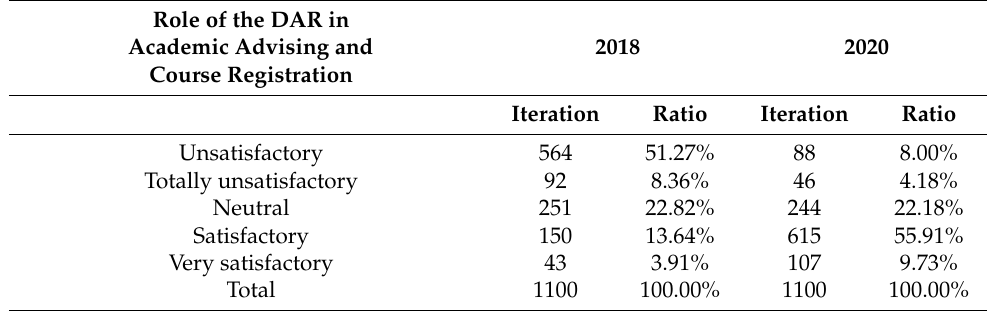
Table 11. Distribution of student numbers according to their feedback on the role of the DAR in